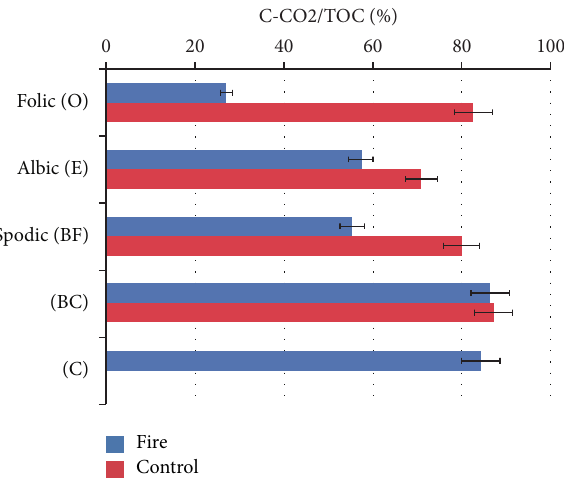
Figure 5: PCM content in control and fire-affected